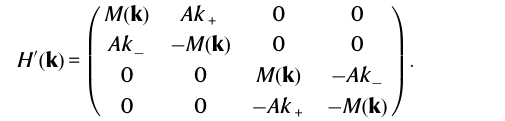
respectively. b The calculated spin up component P ↑ in each LL wavefunction. c , d Same as a , b but for sample 1446. d The 0 − and 1 LLs are both 100% spin-down polarized and therefore overlap with each